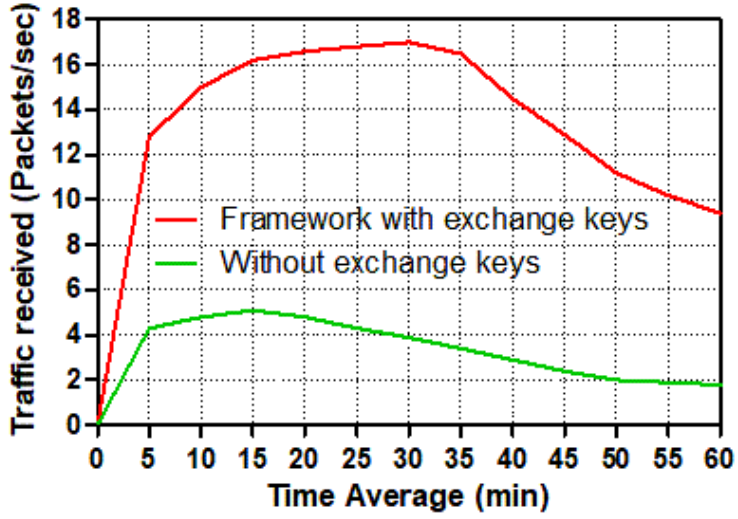
Figure 11. Traffic received (packets/s) in a smart meter for different tasks.